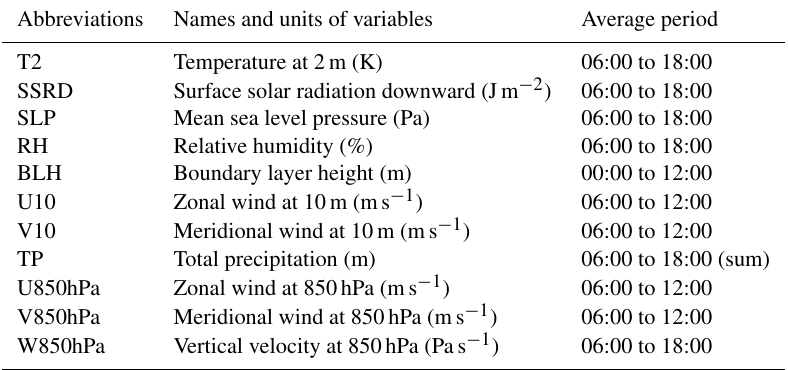
Table 1. Summary of the meteorological controlling factor variables and the respective times of day considered in their averages. The motivation behind each selected time period is provided in the main text. Note: a positive zonal wind means westerly; positive meridional wind means southerly; positive vertical velocity means downward